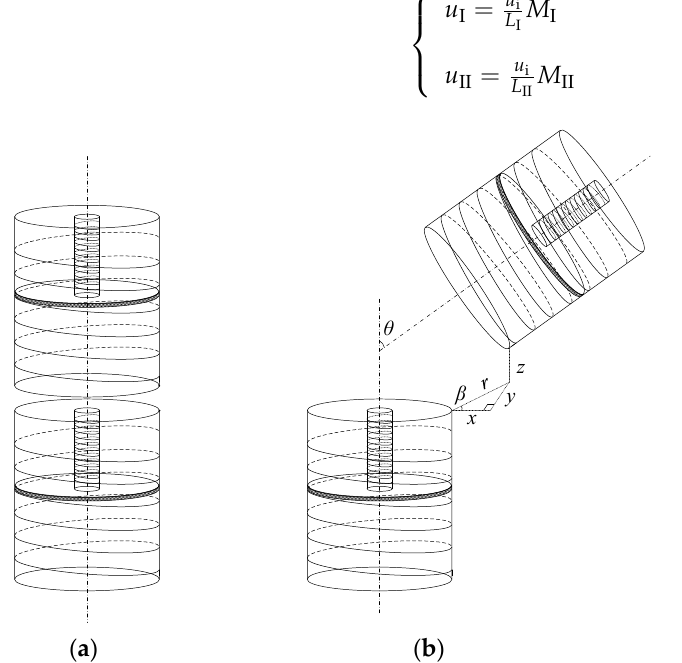
Figure 4. Schematic diagram of the measuring unit based on double mutual inductance voltage contour method. ( a ) Initial state without relative displacement; ( b ) Relative displacement occurred along the azimuth angle β .